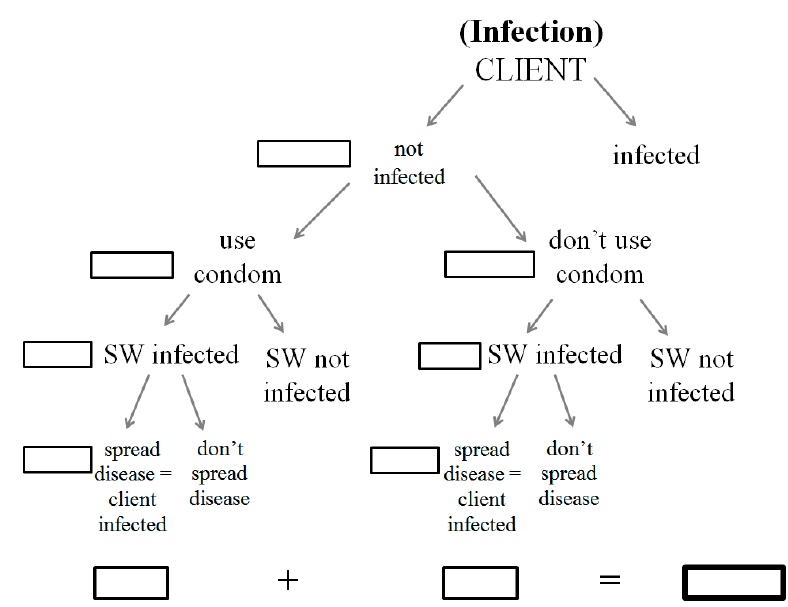
Figure A5. Probability tree of client’s risk of infection.